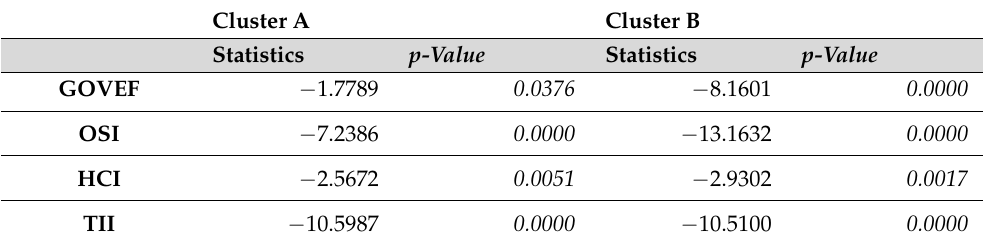
Table 4. LLC unit root test results.